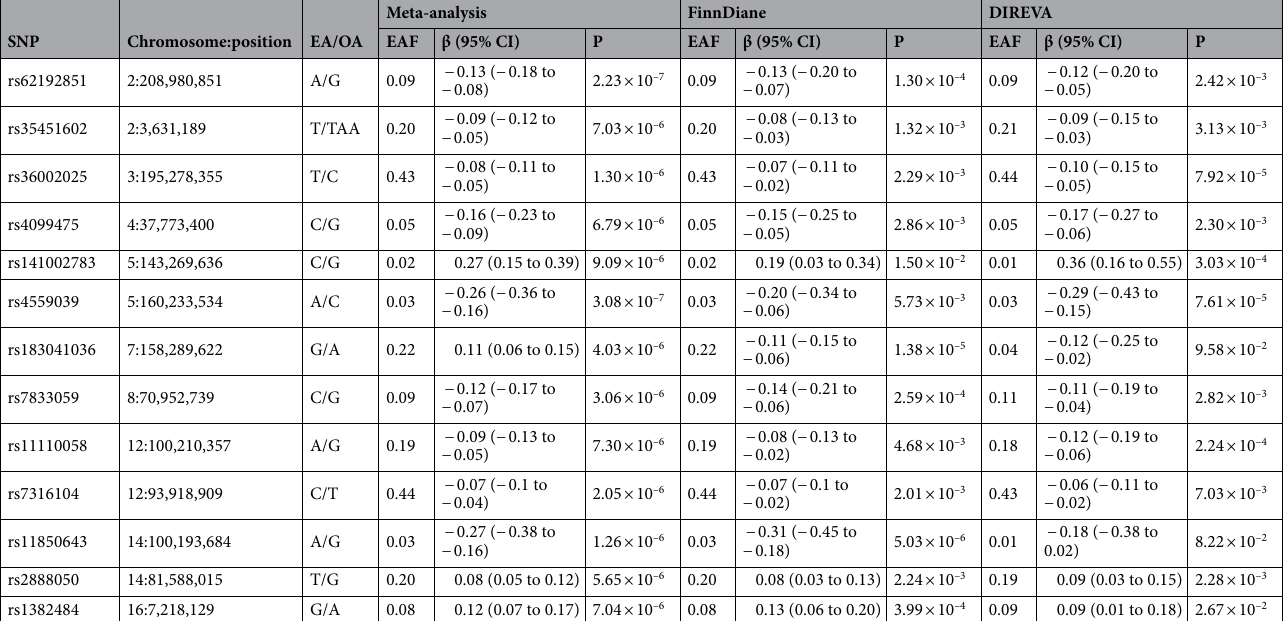
Table 2. The top variant of each locus reaching suggestive significance (P < 1 × 10 –5 ) in the combined meta- analysis performed on the FinnDiane and DIREVA GWAS, as well as their results in the separate GWAS. SNP single nucleotide polymorphism, EA/OA effect allele/other allele, EAF effect allele frequency.